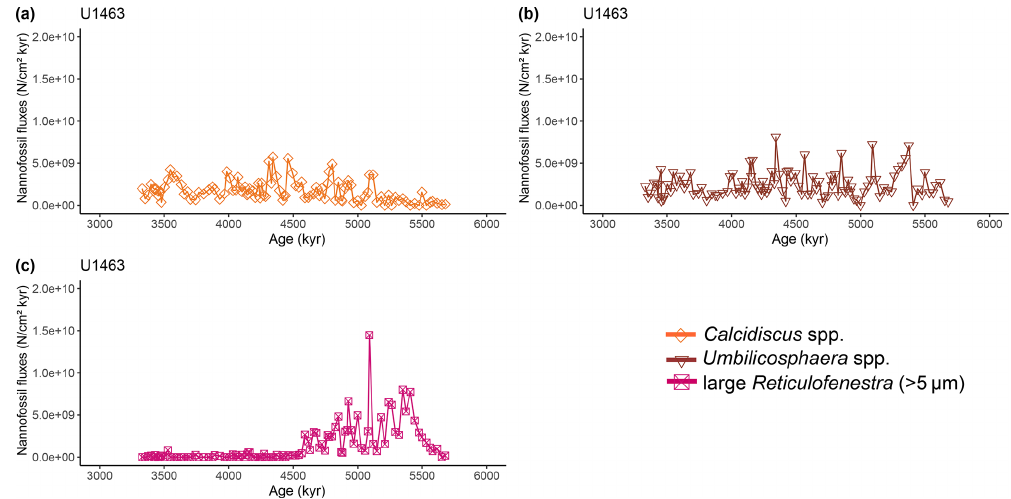
Figure A7. Latest Miocene to early Pliocene nannofossil fluxes (NAR; Ncm − 2 kyr − 1 ) of commonly occurring calcareous nannofossil species at IODP Site U1463. (a) Calcidiscus spp. (orange diamonds), (b) Umbilicosphaera spp. (brown triangles), and (c) large ( > 5µm) Reticulofenestra (purple-pink squares). Error bars of maximum replication error ( ± 15%; Bordiga et al., 2015) were too small and therefore impaired the visual inspection of the figure. However, they are available as part of the source data of this paper.